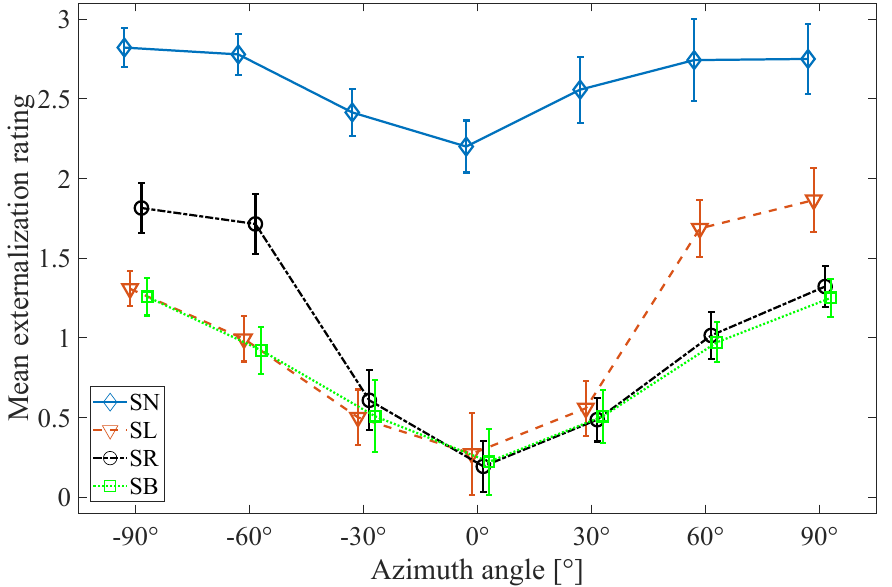
Figure 8. Mean externalization ratings from zero (the sound is in my head) to three (the sound is externalized and at the position of the loudspeaker) across listeners for the “SN” (diamonds), “SL” (triangles), “SR” (circles), and “SB” (squares) conditions in different azimuth angles. The error bars indicate the standard deviations of the mean